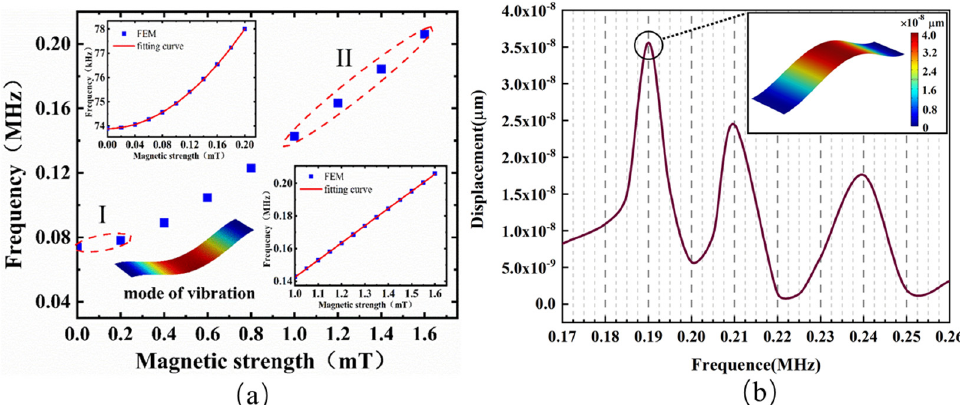
Figure 4. ( a ) Resonance frequency versus external magnetic field in the range of 1–1.6 mT. The inset shows the nonlinear change at 0–0.2 mT (I) and the linear change at 1–1.6 mT (II); ( b ) amplitude versus frequency for graphene resonator when the magnetic field was 1.4 mT. (Inset) Free vibration mode shapes of graphene sheets.